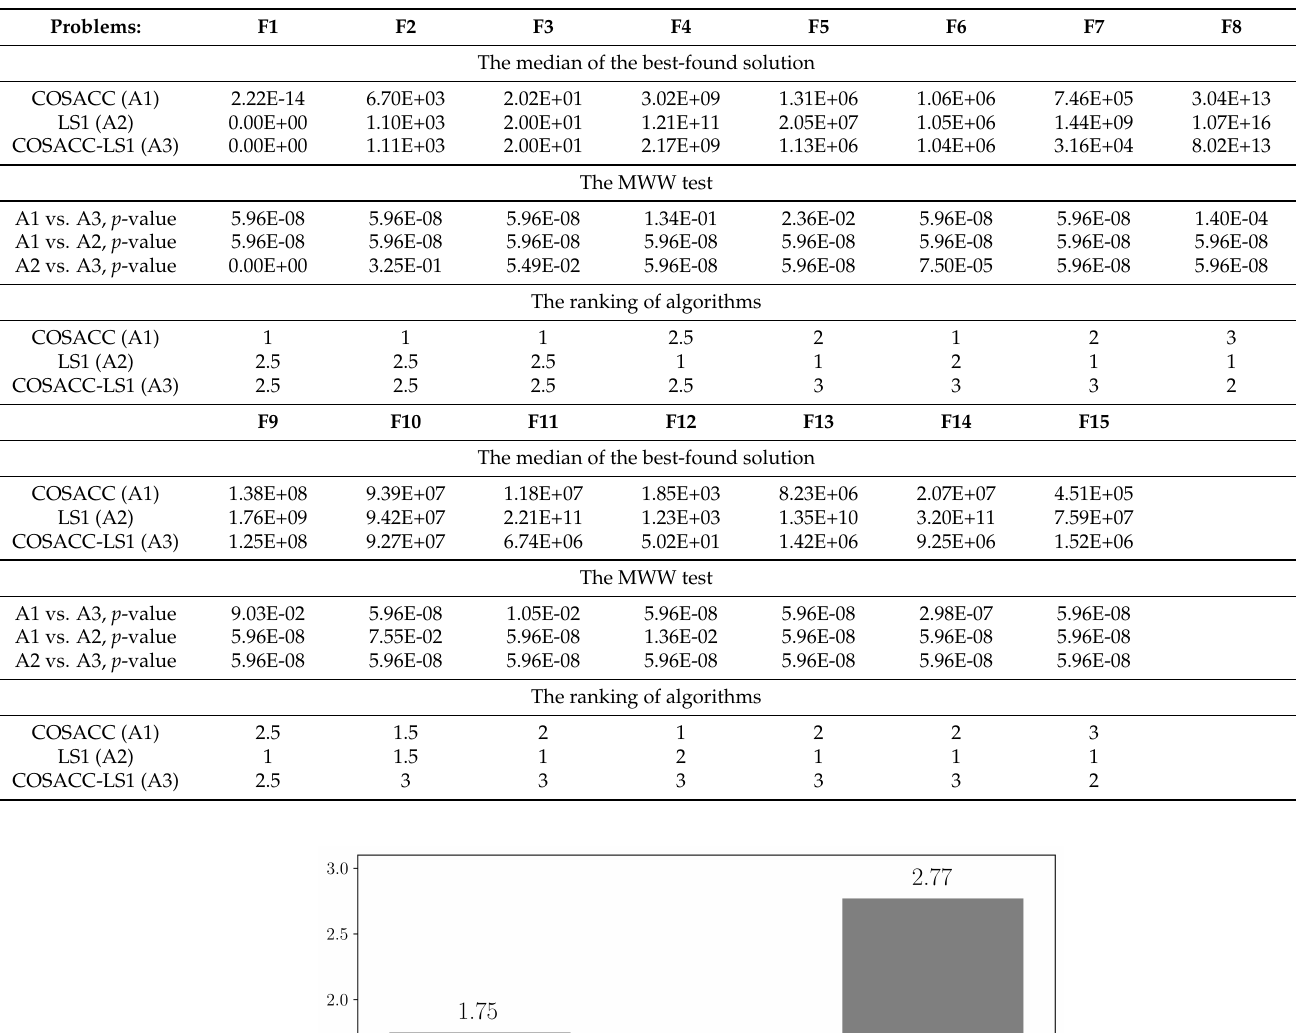
Table 4. The comparison of algorithms.